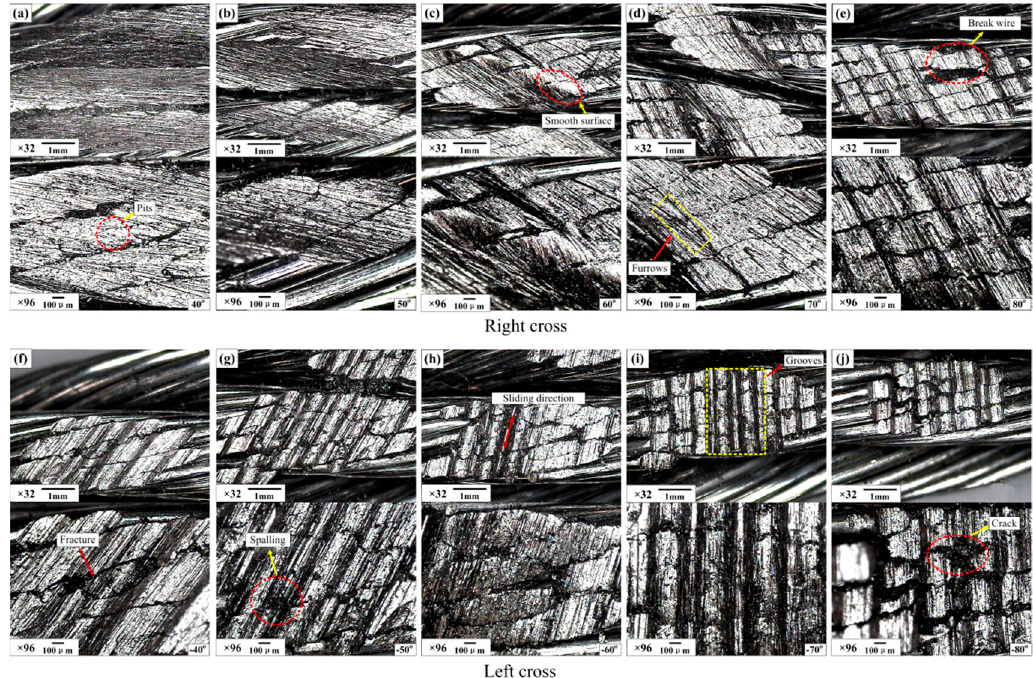
Figure 15. Industrial microscope images of the wear surface of the upper loading rope for different conditions ( x : 20 mm; v : 12 mm/s). ( a – e ): right cross contact; ( f – j ): left cross